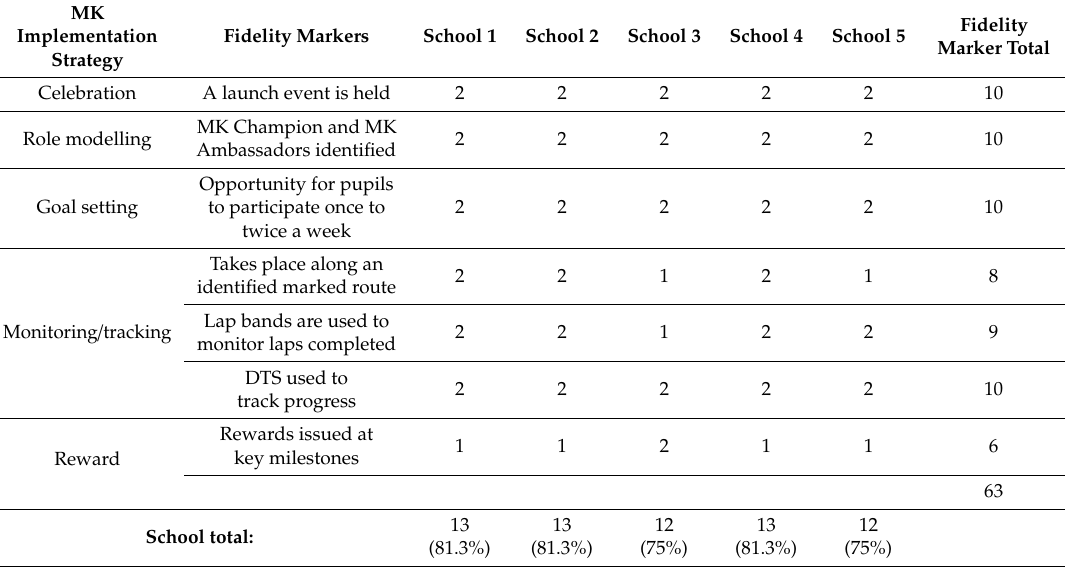
Table 4. Summary of the assessment of schools’ fidelity to Marathon Kids